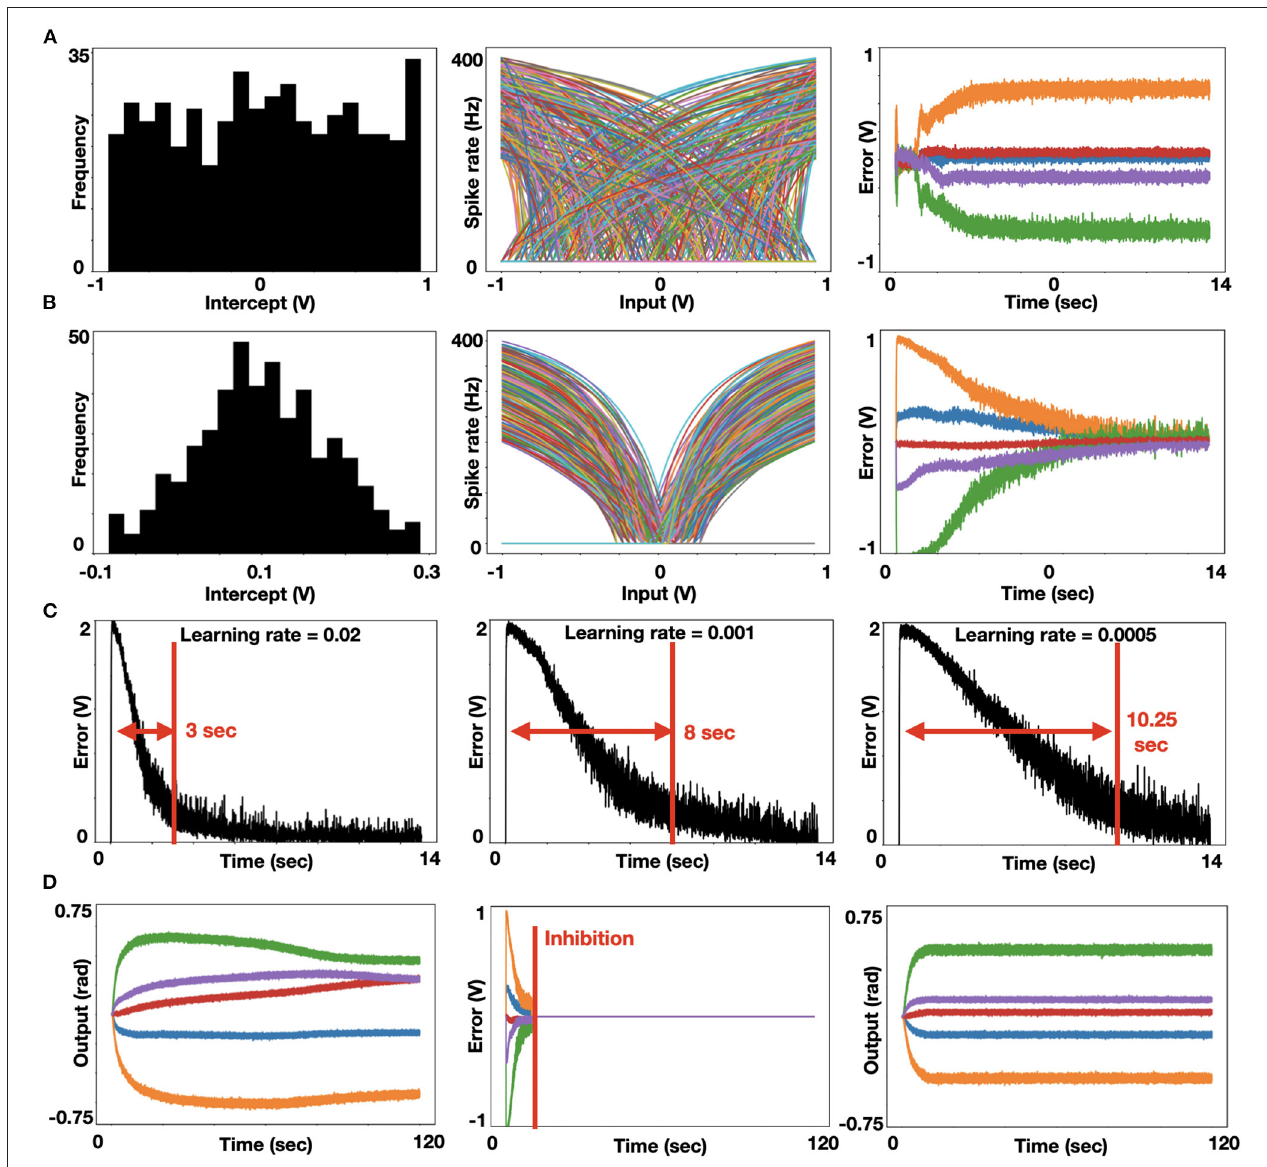
FIGURE 2 | Analysis of neuromorphic IK. (A) Histogram of uniformly distributed intercepts (left). The uniformly distributed intercepts as reflected in the tuning curve’s distribution, in which spike rate as a function of input is presented for each neuron. Each color represents a different neuron in the ensemble (middle). These uniformly distributed intercepts lead to a non-uniform spanning of the representation space, thus driving non-zero-converging errors. Each color represents a joint’s error following the colors’ mapping taken in Figure 1 and panel D below (right); (B) Histogram of trigonally distributed intercepts (left). Tuning curve’s distribution (middle). These triagonally distributed intercepts lead to a uniform spanning of the representation space, thus driving zero-converging errors. Each color represents a joint’s error (right); (C) Error value for the base joint (indicated otherwise in orange) with three learning rates: 0.02, 0.001, and 0.0005 (left to right), demonstrating that lower learning rates induce slower error convergence. (D) . Learned joint configuration with non-inhibited learning leads to a non-stabled joint configuration, as the arm is continuously trying to improve its conformation in space (left). The introduction of an inhibition signal (marked red) is zeroing the error signal (middle). Learned joint configuration with inhibited learning leads to a stable joint configuration